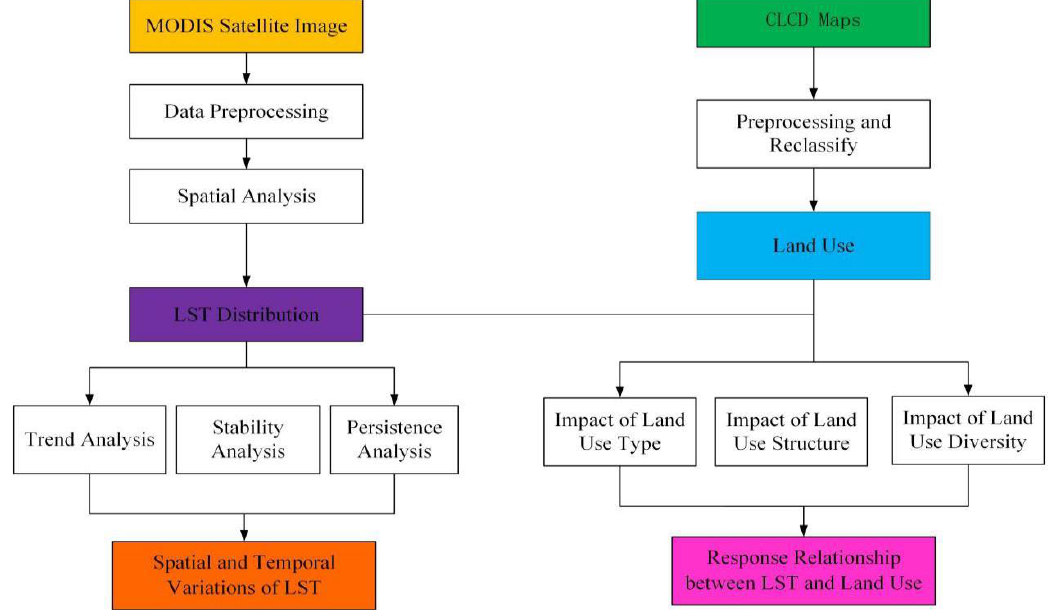
Figure 4. The research program in this study.